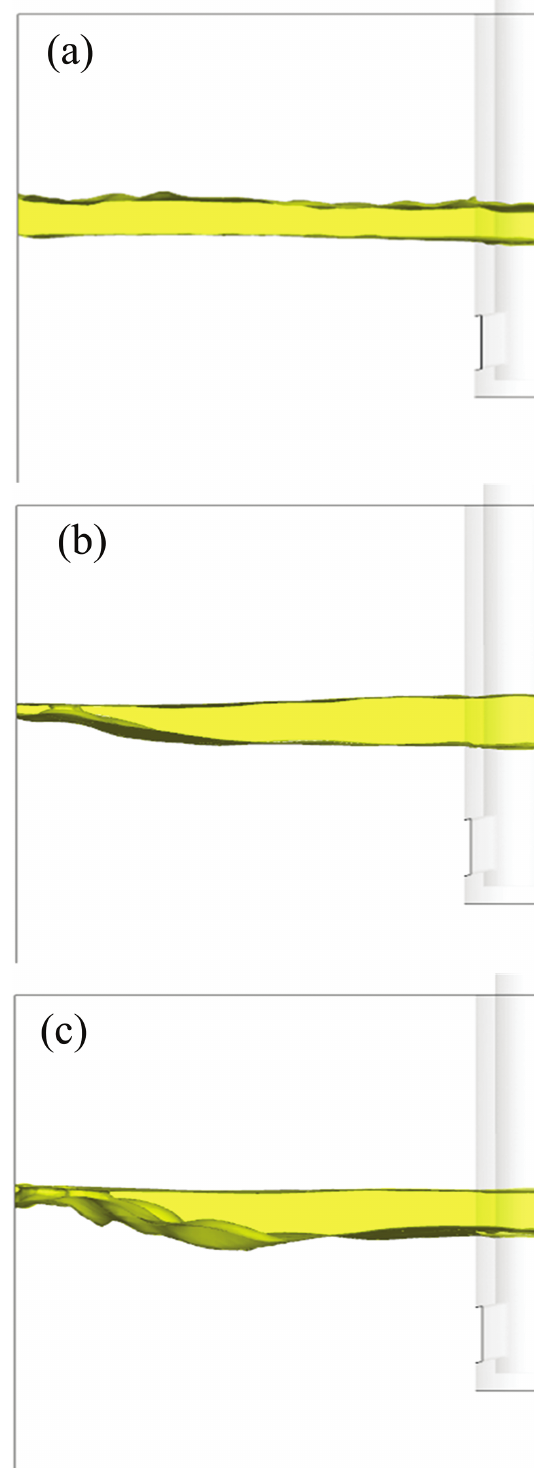
Figure 5: Experiment observation of the fluctuation of the oil layer at different times: (a) 0.2 s, (b) 0.4 s, and (c) 0.6 s.